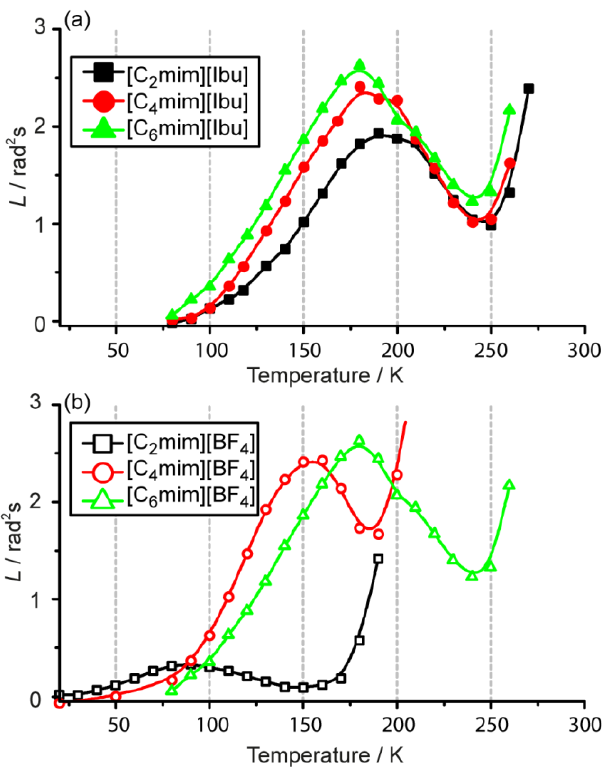
Figure 3. The temperature dependence of the motional parameter L ≈ 10 11 < α 2 > τ c for the nitroxide radical N1 dissolved in ( a ) [C n mim][Ibu] and ( b ) [C n mim][BF 4 ]. Solid lines guide the eye.